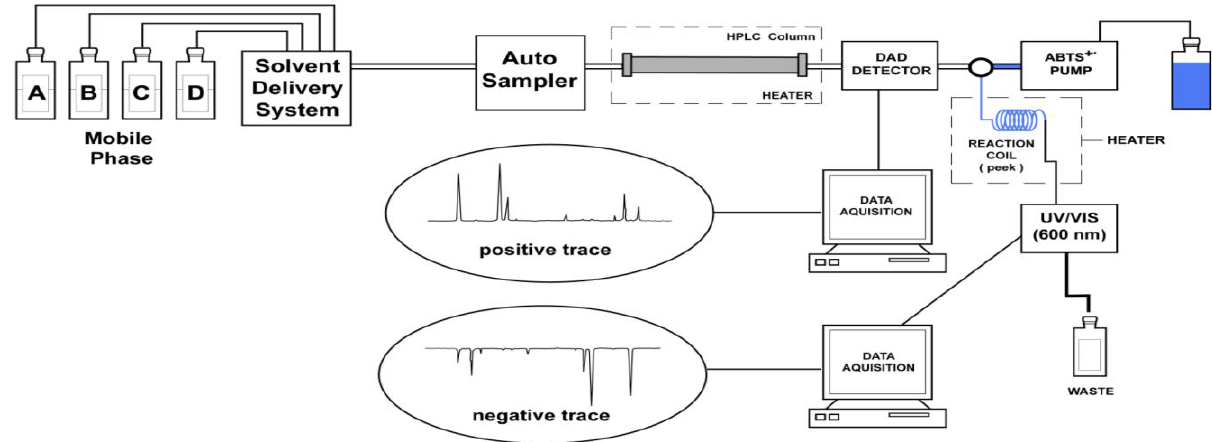
Figure 3. Set-up for the HPLC-ABTS •+ on-line